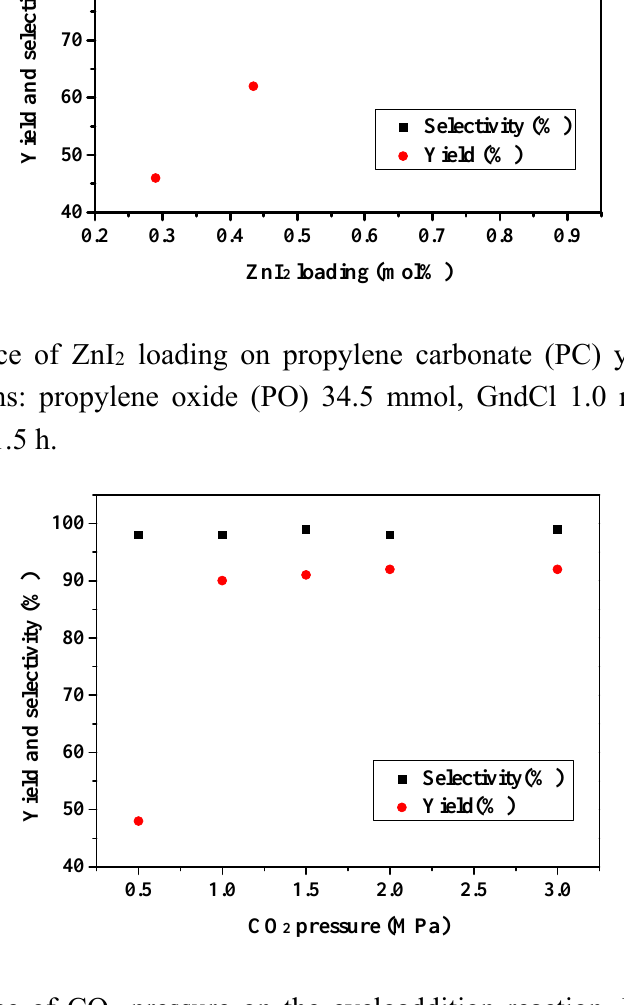
Figure 2. Influence of CO 2 pressure on the cycloaddition reaction. Reaction conditions: PO 34.5 mmol, GndCl 1.0 mmol, ZnI 2 0.2 mmol, 100 °C, 1.5